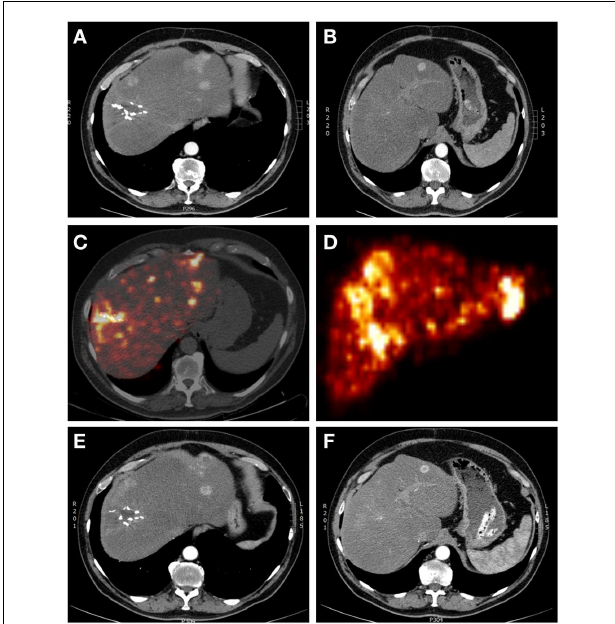
FIGURE 1 |A 65-year-old male patient with multifocal recurrent hepatocellular carcinoma (HCC) 6months after resection of a HCC in liver segment 7–8 . (A,B) Arterial phase contrast-enhanced CT showing operation clips in situ after resection of the primary HCC and multiple sites of contrast enhancement (with wash-out on delayed images – not shown). (C) Yttrium-90 PET-lowdose CT and (D) maximum intensity projection after treatment with 1.7GBq 90 Y labeled SIR-Spheres, showing markedly increased uptake of SIR-Spheres at the site of resection and multifocal in both right and left liver lobes, with clear right-sided predominancy. (E,F) Arterial phase contrast-enhanced CT showing response with central necrosis in tumor lesions, with no significant changes in liver volume.